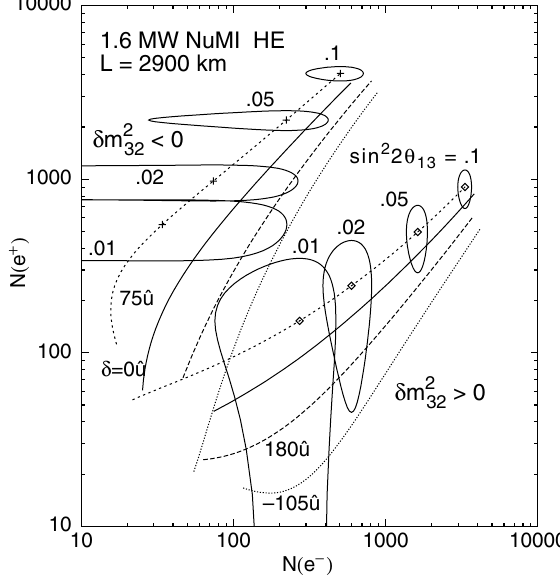
FIG. 7. Three-sigma error ellipses in the (cid:18) N (cid:8) e (cid:2) (cid:9) ; N (cid:8) e (cid:1) (cid:9)(cid:20) ! (cid:2) ! (cid:28) (cid:2)(cid:2) and (cid:28) (cid:2)(cid:2) oscillations in a plane, shown for (cid:2) (cid:3) e (cid:3) e NuMI-like high-energy neutrino beam driven by a 1.6 MW proton driver. The calculation assumes a liquid-argon detector with the parameters listed in [28], a baseline of 2900 km, and 3 years of running with neutrinos, 6 years running with FIG. 8. Three-sigma error ellipses in the (cid:18) N (cid:8) (cid:3) (cid:2)(cid:9) ; N (cid:8) (cid:3) (cid:1)(cid:9)(cid:20) antineutrinos. Curves are shown for different CP phases (cid:6) plane, shown for a 20 GeV neutrino factory delivering 3 : 6 (cid:5) j (cid:4) with j (cid:6)m 2 (as labeled), and for both signs of (cid:6)m 2 10 21 useful muon decays and 1 : 8 (cid:5) 10 21 antimuon decays, with 32 32 (cid:4) 10 (cid:1) 4 eV 2 . 0 : 0035 eV 2 , and the sub-leading scale (cid:6)m 2 a 50 kt detector at L (cid:4) 7300 km , (cid:6)m 2 21 varies along the curves from 0.001 to 0.1, Note that sin 2 2 (cid:5) Curves are shown for both signs of (cid:6)m 2 13 as indicated [79]. the curves from 0.0001 to 0.01, as indicated